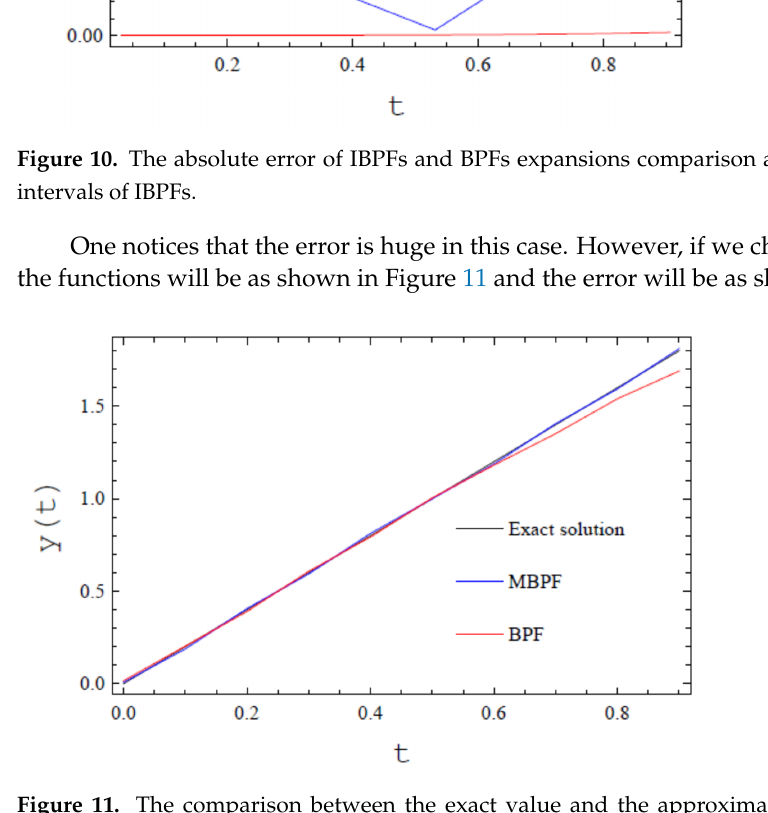
Figure 11. The comparison between the exact value and the approximation of both BPFs and IBPFs solutions.